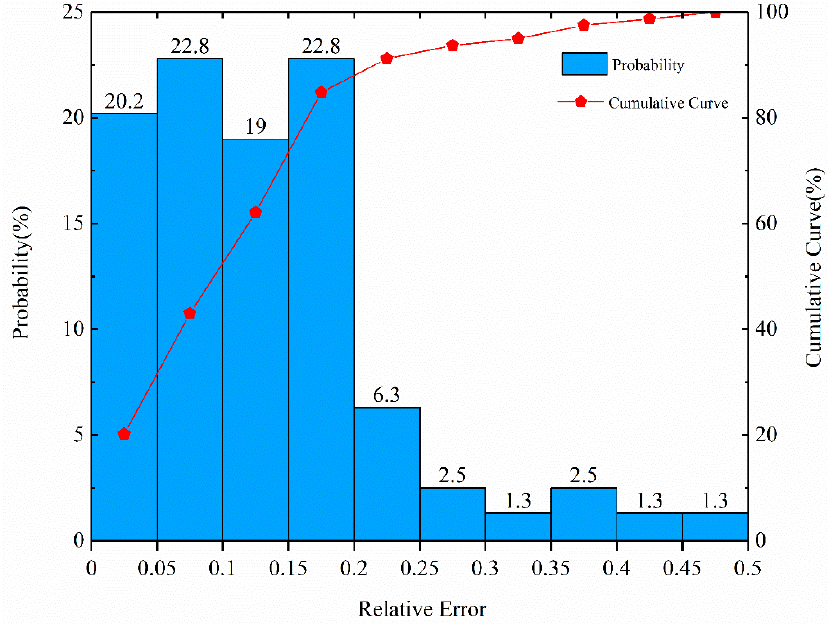
Figure 14. Relative error distribution of fully-connected ANN prediction model.